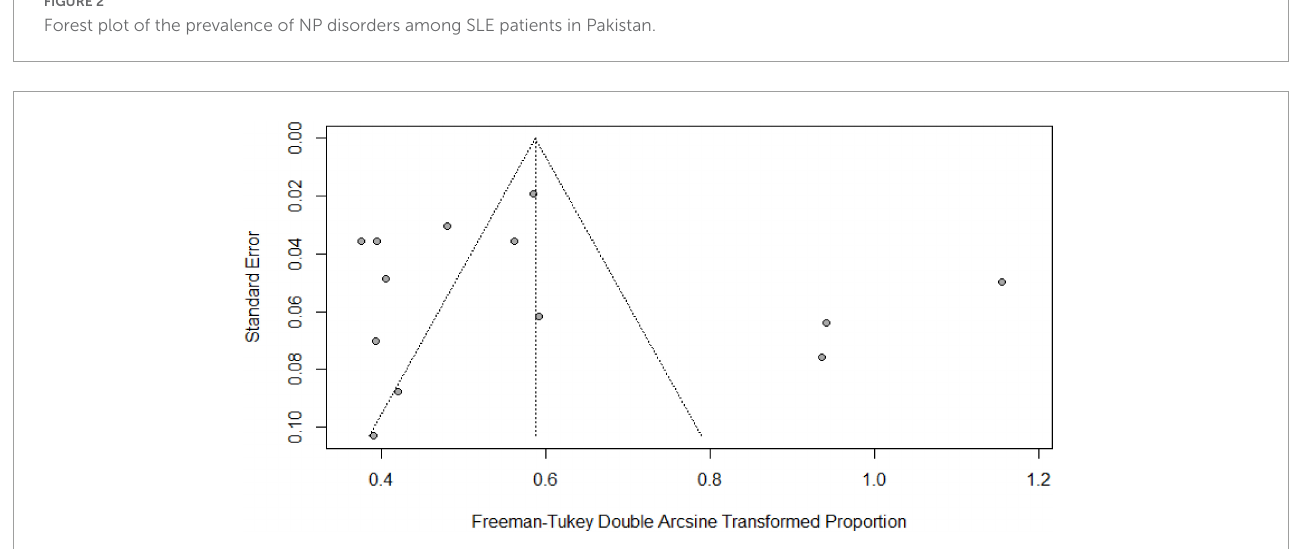
FIGURE3 Funnel plot of the prevalence of NP disorders among SLE patients in Pakistan.